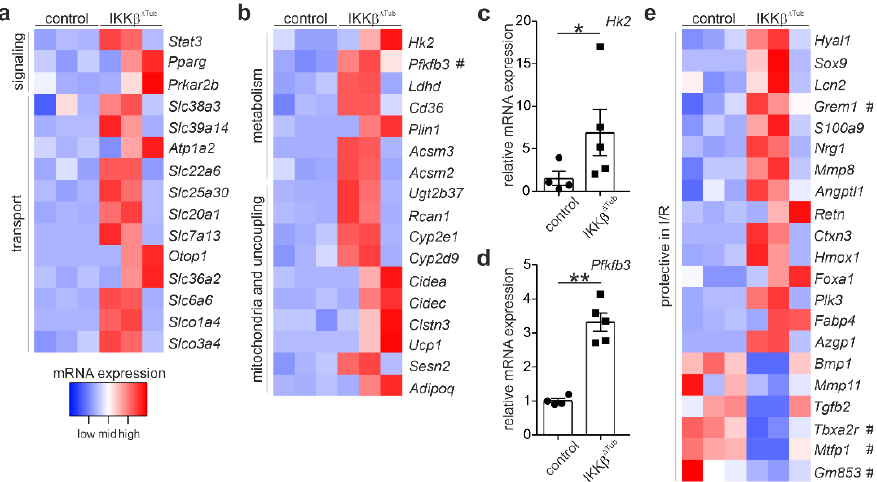
Figure 2. Tubular deletion of IKK β alters baseline gene expression. ( a ) heatmaps of significantly in- creased mRNA of proteins important in signaling transduction and epithelial transport; ( b ) Heatmaps of significantly augmented mRNA expression levels coding for enzymes of metabolism (glycolysis, of lipid uptake, storage and biosynthesis) and mitochondria and mitochondrial uncoupling. IKK β ∆